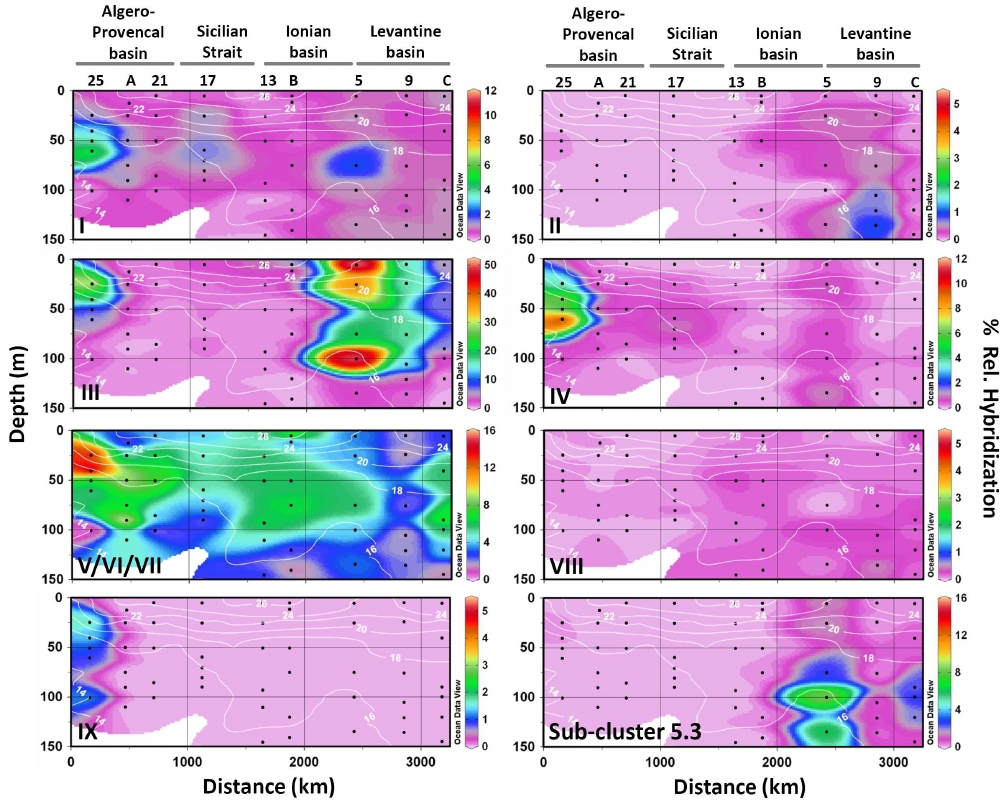
Fig. 5. Vertical distribution of different phylogenetic groups of Synechococcus along the BOUM cruise track, as analyzed by dot blot hybridization using 16S rRNA gene specific oligonucleotide probes targeting sub-cluster 5.1 clades I to IX and sub-cluster 5.3. See Table 1 for correspondence to sequenced strains. Details of panels are as described in Fig. 2. Note the different ranges of % relative hybridization values between